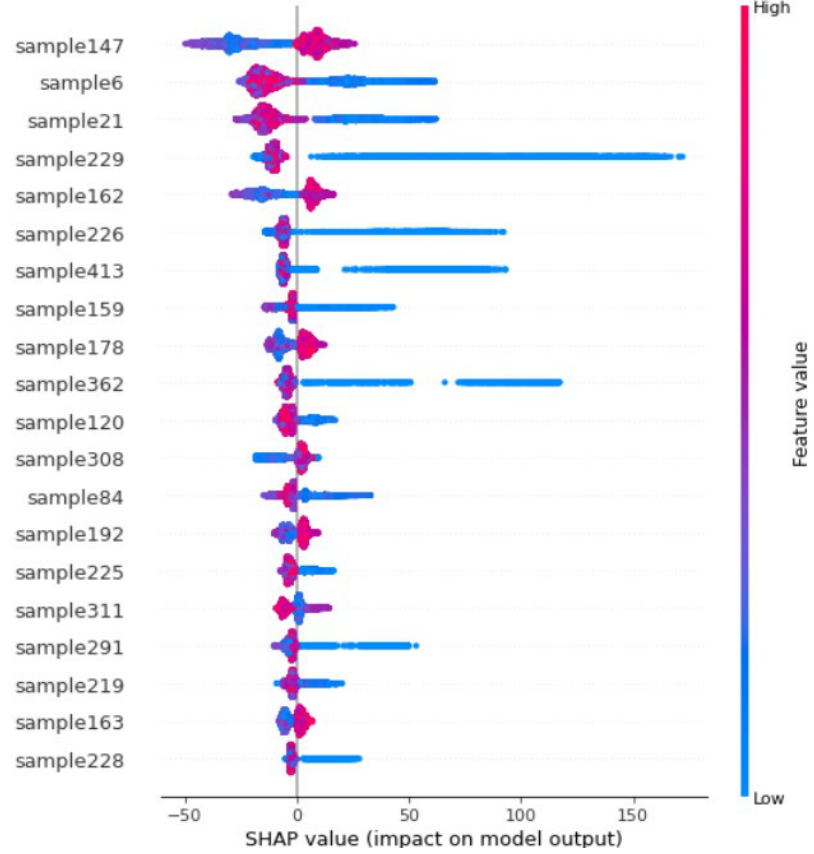
Figure 15. Summary Plot of samples impact/influence on the estimation.